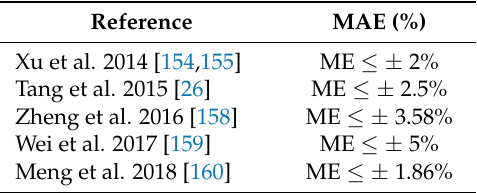
Table 14. MAE/ME of the PIO-based SOC estimation method.